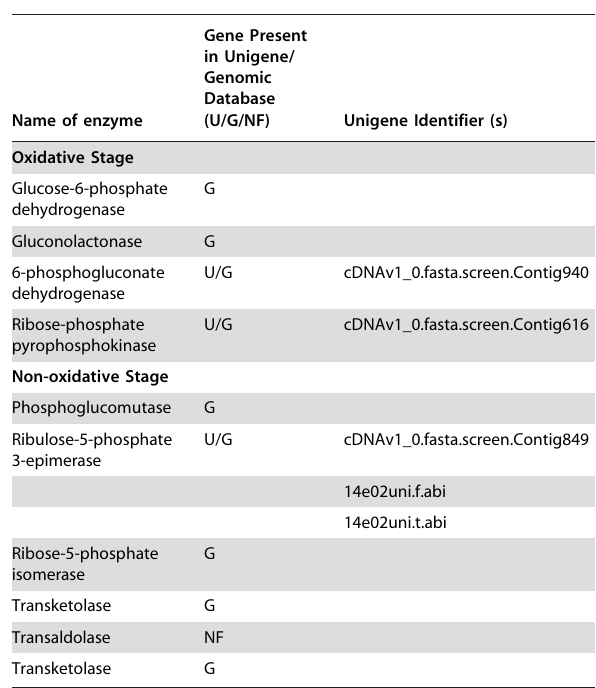
Table 2. KEGG biochemical pathway mappings for P. carinii